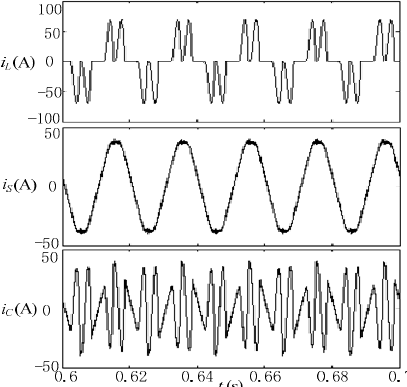
Figure 13. Steady state waveform of the 250 µ H inductor.